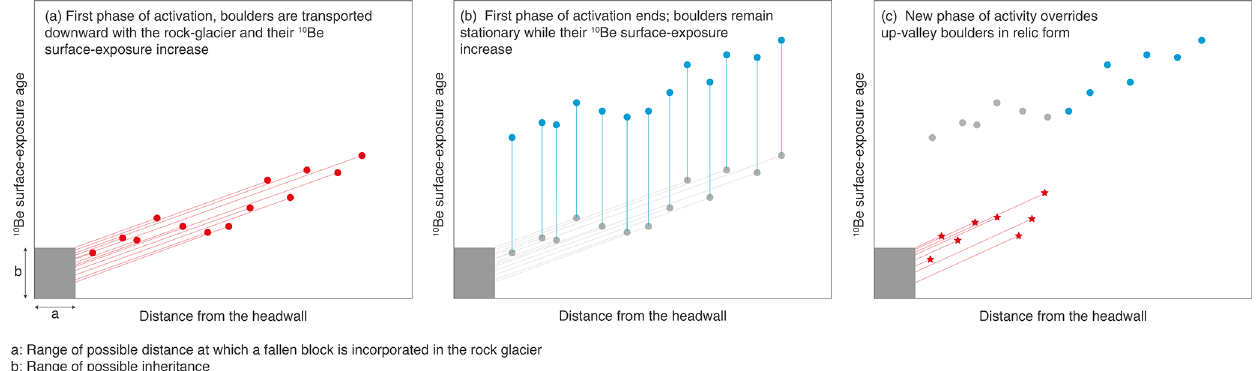
Figure 10. Schematic interpretation of the evolution of the 10 Be surface-exposure age patterns as a function of distance from the headwall, considering two phases of rock glacier activity and stochastic rockfall delivery of boulders. See Sect. 5.3 for